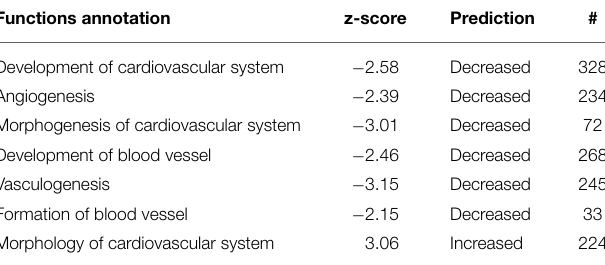
TABLE 4A | Subcategory functions for genes annotated to Cardiovascular System along with predictions for activation